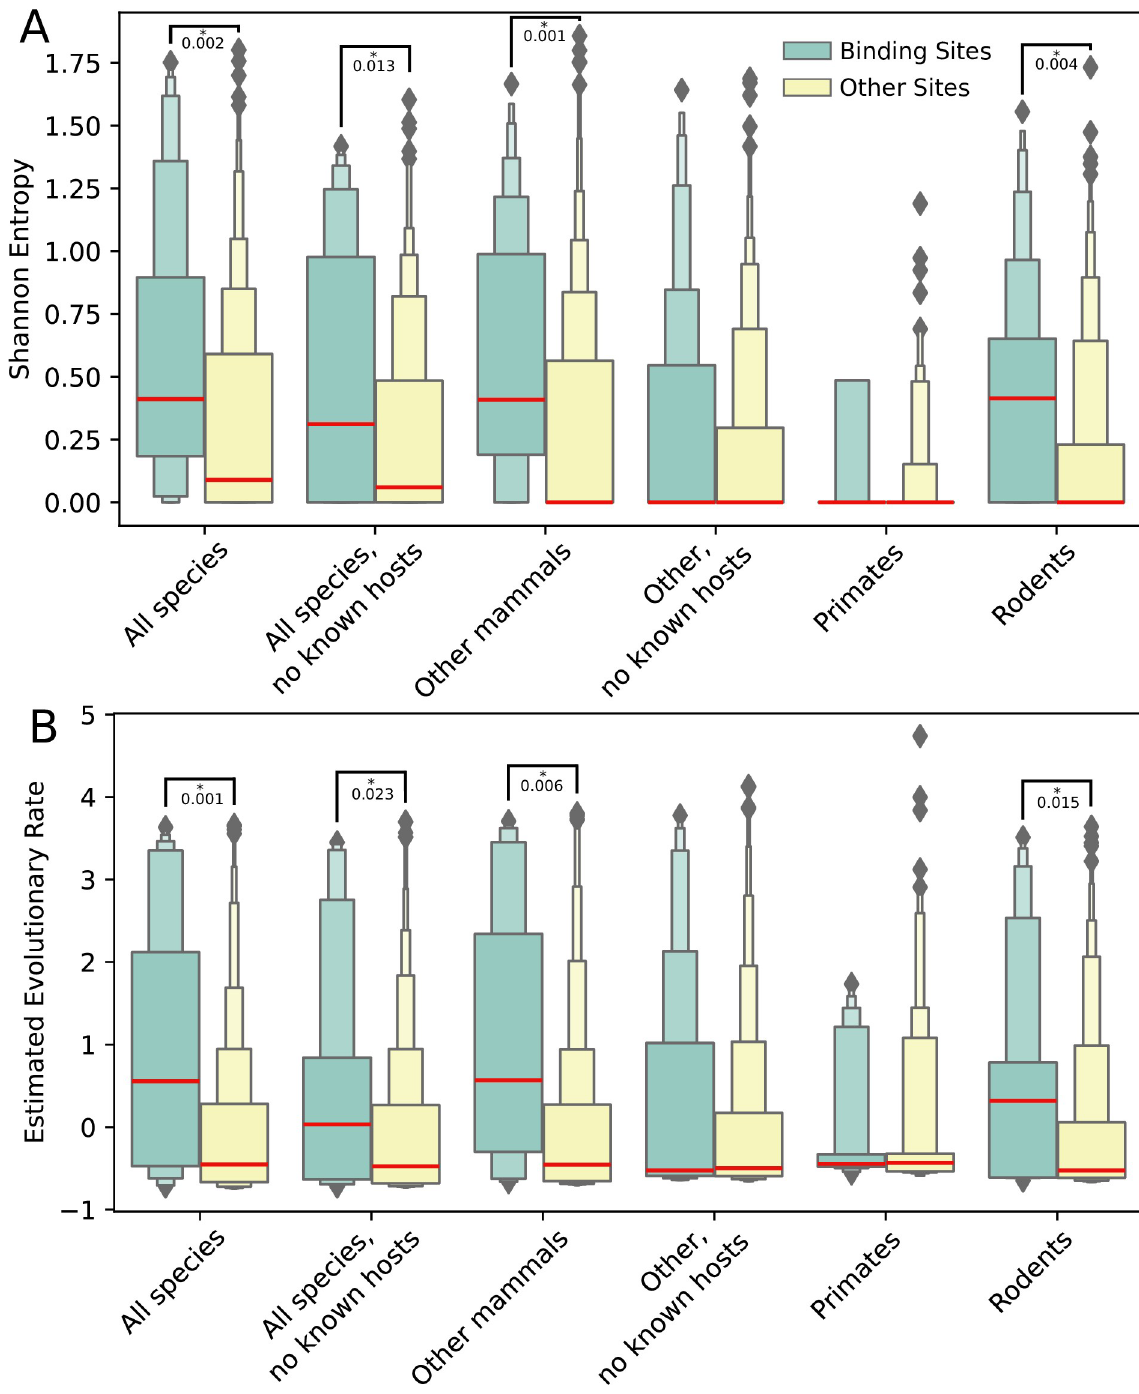
Fig 2. Variation and evolution across the ACE2 receptor at both the spike-binding and other surface-exposed extracellular regions. Letter-value (or boxen) plots of (A) Shannon entropy and (B) relative evolutionary rate estimates for sites within ACE2 that either bind (green) or do not bind (yellow) the SARS-CoV-2 spike protein, computed using sequences from each of the six species groups (all considered mammalian species, all mammalian species excluding bats, civets and pangolins—i.e., excluding several species that are known Laurasiatheria hosts of SARS-like viruses, along with additional bat species—mammalian species excluding primates and rodents, mammalian species excluding primates, rodents, bats, civets and pangolins, primates only, and rodents only). In letter-value plots, the widest boxes show half the data (from the 25th to 75th percentiles), while each successively narrower box shows half the remaining data. Median values are shown in red. For each measure and species group, comparisons between the binding sites and all other sites that yield P-values less than 0.05 (MWU) are